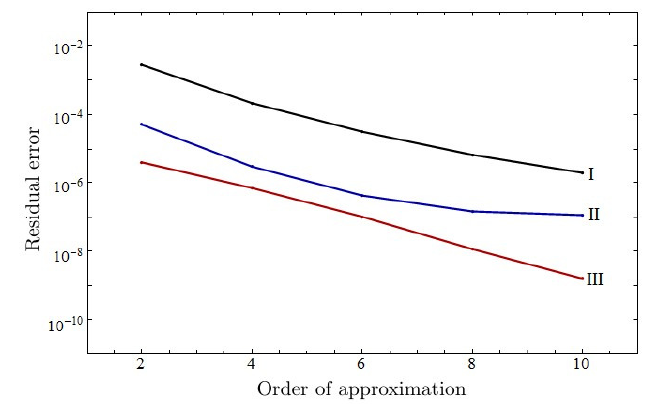
Fig. 2 Average square residual error versus order of approximation for: (I) Mn = 15 , C = 0 . 001 , λ 1 = 0 . 3 , γ = 1 . 0 , and δ = − 2 . 0, (II) Mn = 20 , C = 0 . 01 , λ 1 = 0 . 2 , γ = 0 . 5 , and δ = − 0 . 5, (III) Mn = 10 , C = 0 . 1 , λ 1 = 0 . 1 , γ = 0 . 1 , and δ = − 1 .